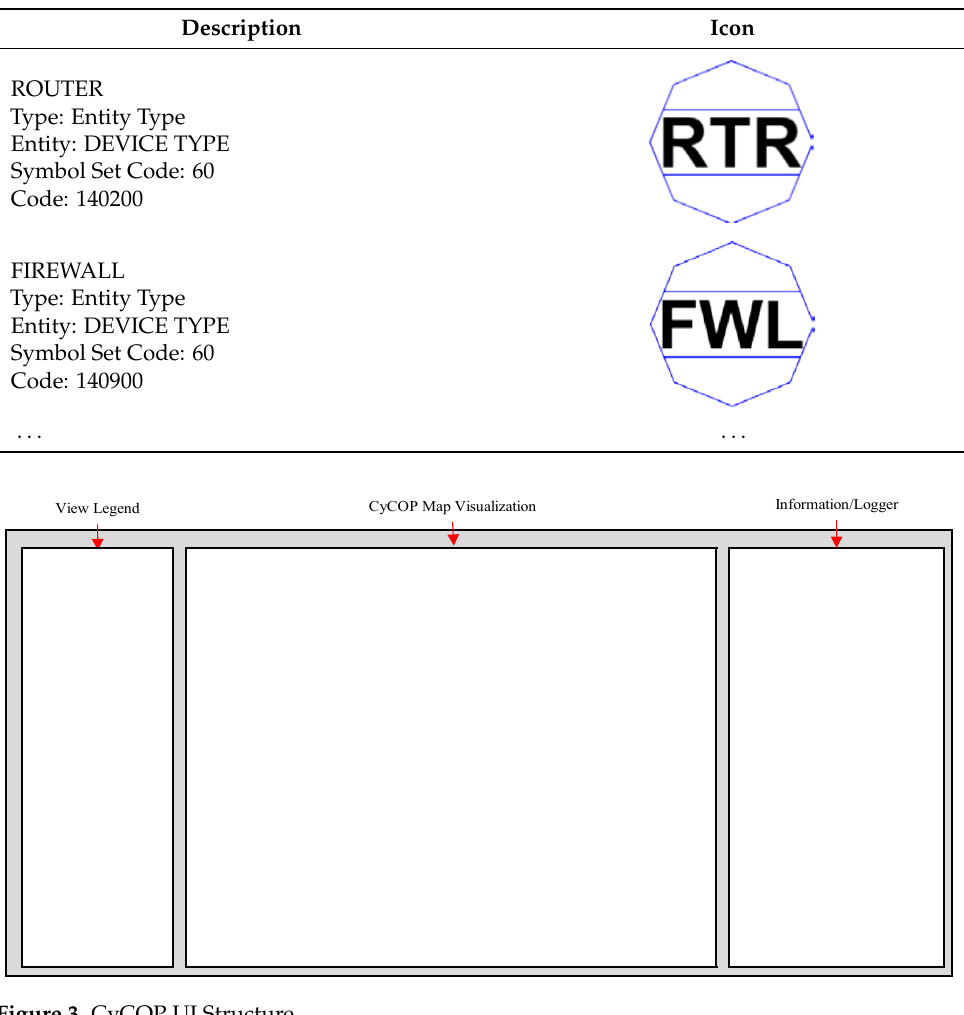
Figure 2. Cyberspace Symbol Components. Figure 3. CyCOP UI Structure. Table 7. Parts of Cyberspace Icons.